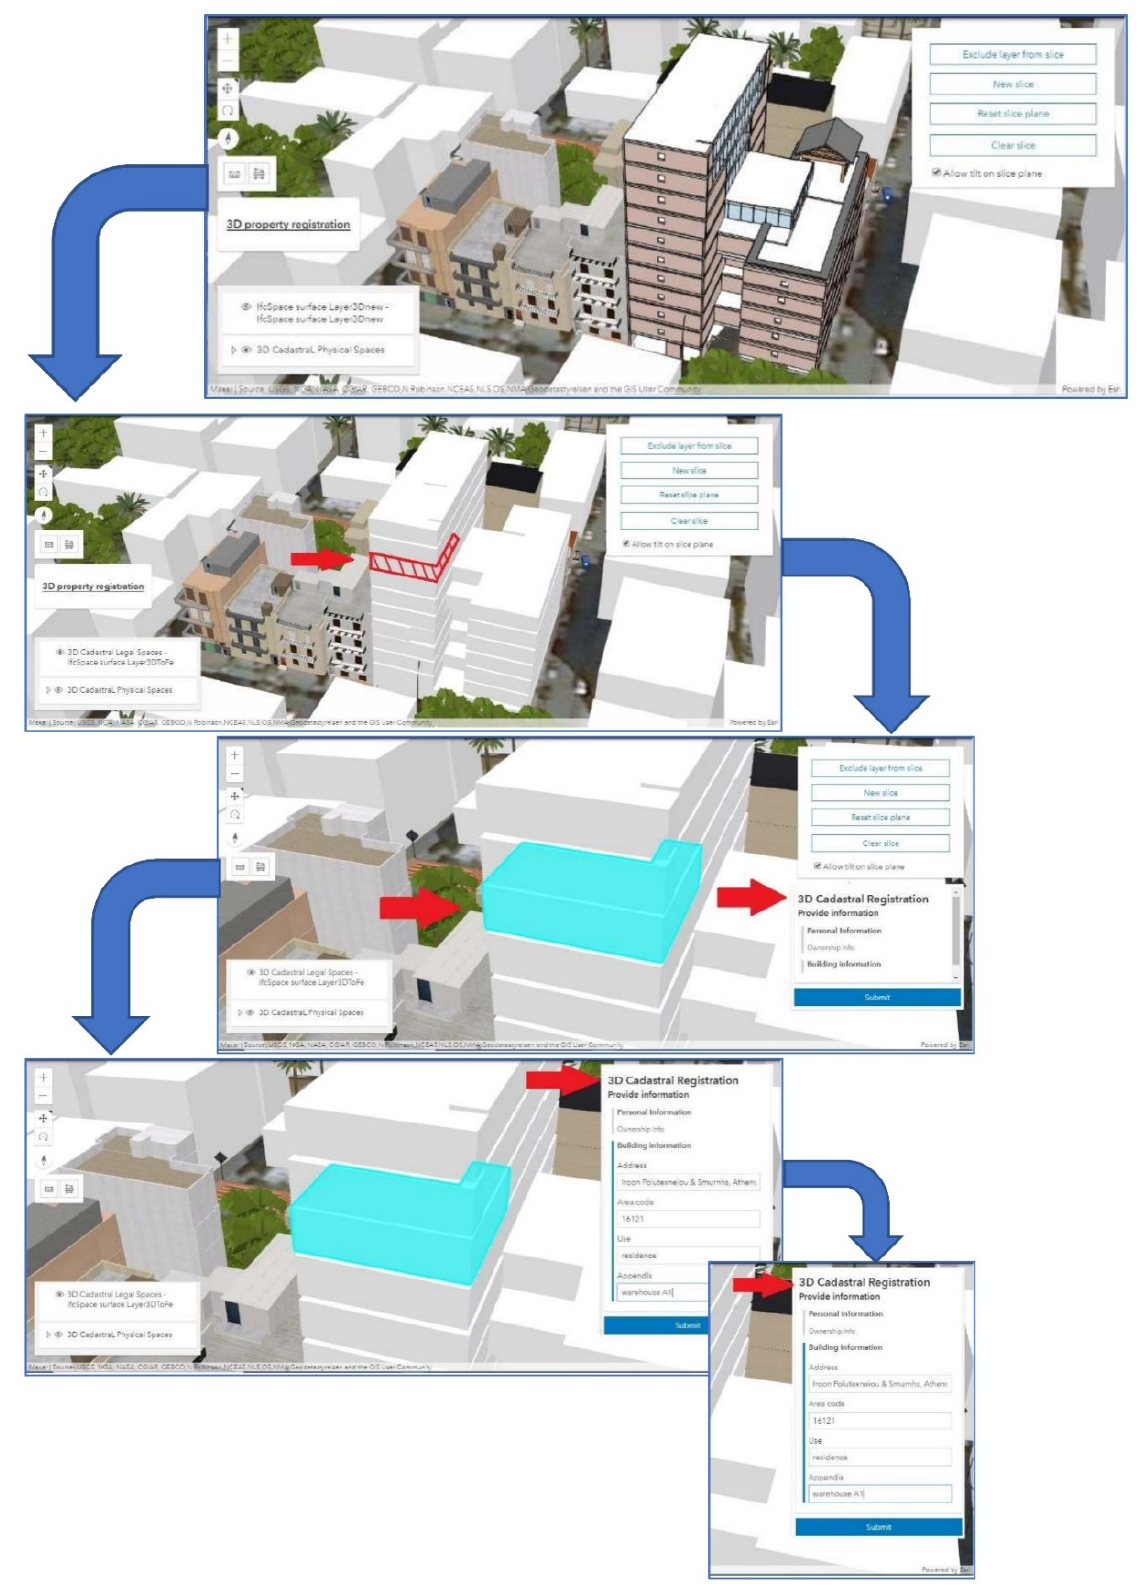
Figure 5. Example of the registration process through the developed web application, including: ( first row ) the identification of the desired property; ( second row ) the property selection; ( third row ) the insertion of the necessary information concerning the rights holder; and ( fourth row ) the building.